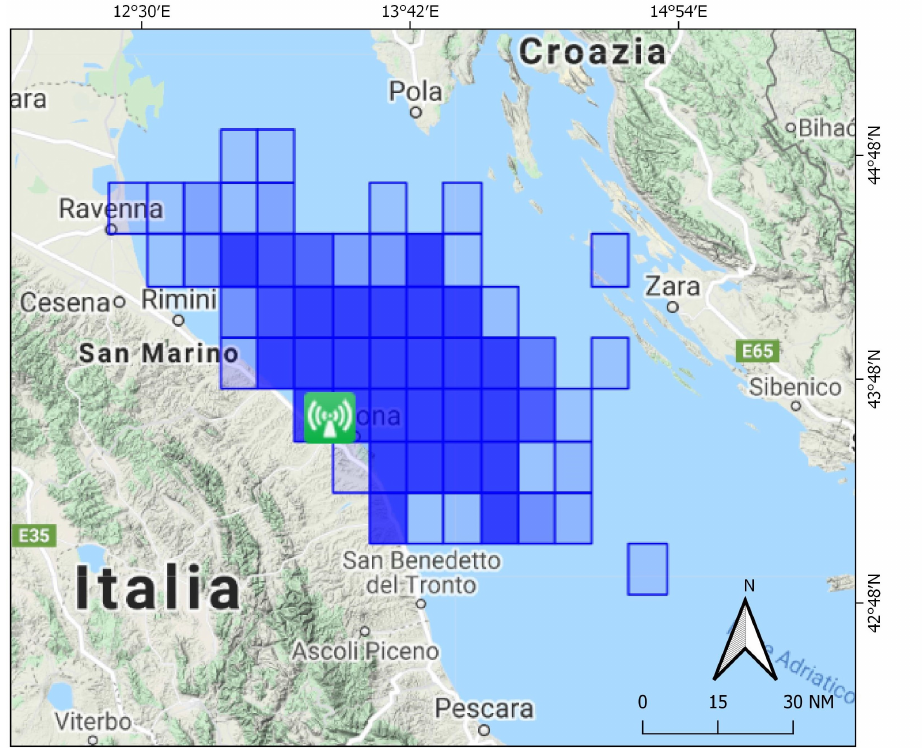
Figure 1. t-AIS data coverage (Source: Marin Traffic, Station #82). The blue-colored areas reflect the quality of data coverage in each grid